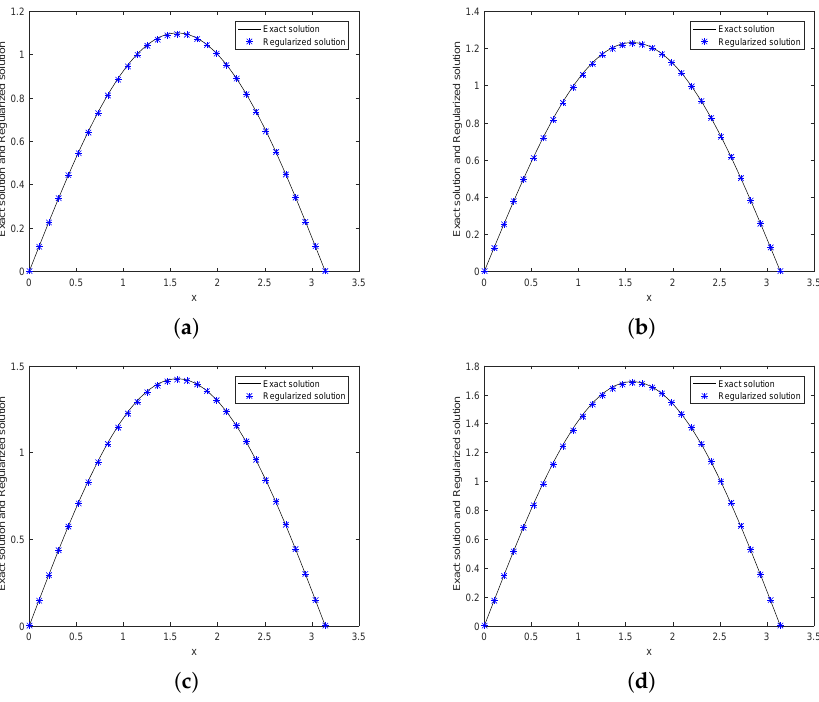
Figure 1. k = 0.5, ε = 0.01, γ = 2, the exact and regularized solutions; ( a ) y = 0.4, ( b ): y = 0.6, ( c ) y = 0.8, ( d ) y = 1.